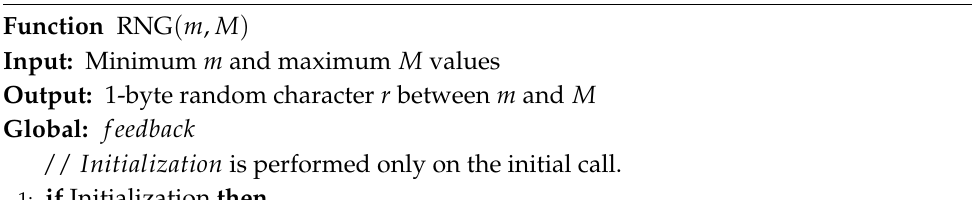
Algorithm 1 RNG of Magniber v2